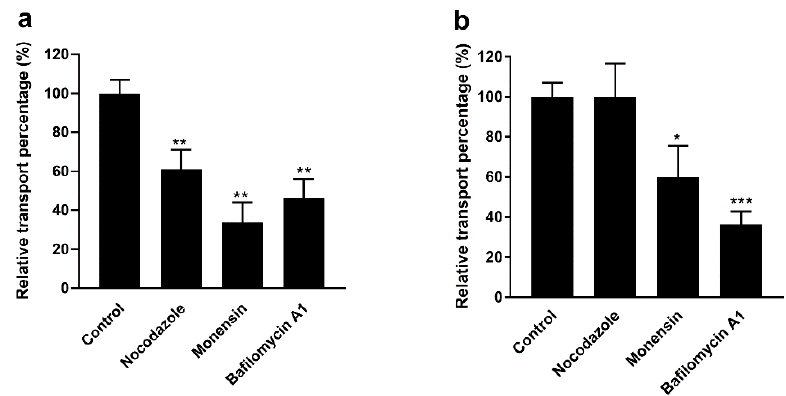
Figure 6. Uptake experiments of F-PM and F-PG after addition of intracellular inhibitors. ( a ) The effect of intracellular inhibitors on F-PM transport; ( b ) the effect of intracellular inhibitors on F-PG transport. * p < 0.05; ** p < 0.01; *** p < 0.001.